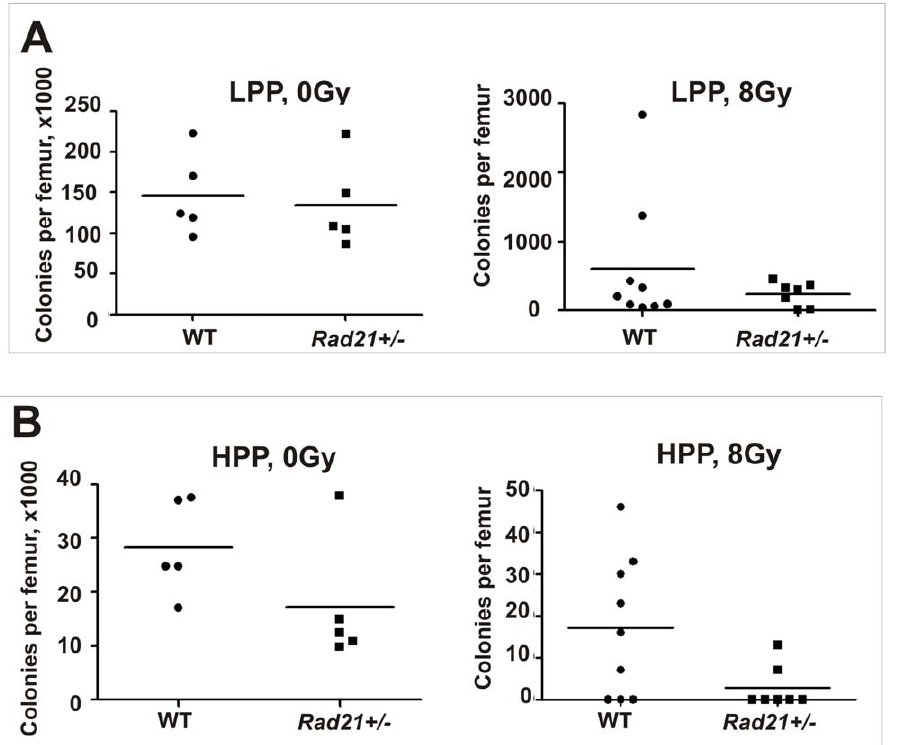
Figure 7. Basal and post-irradiation cloning efficiencies of bone marrow low proliferative potential-colony forming cells (LPP-CFC) and high proliferative potential-colony forming cells (HPP-CFC). Irradiated animals were assayed 10 days post 8Gy WBI. Data generated from two independent experiments and total animals used: WT 0Gy n=5; 8Gy n=10; Rad21 + / 2 0Gy n=5, 8Gy n=7. Horizontal bars represent mean. A . LPP -CFC. B .